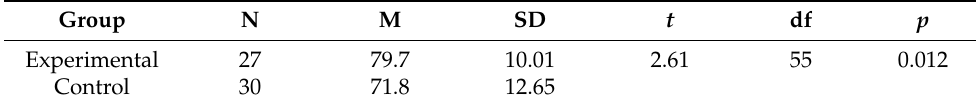
Table 3. Results of the t -test of the final paper-and-pencil test scores. Group